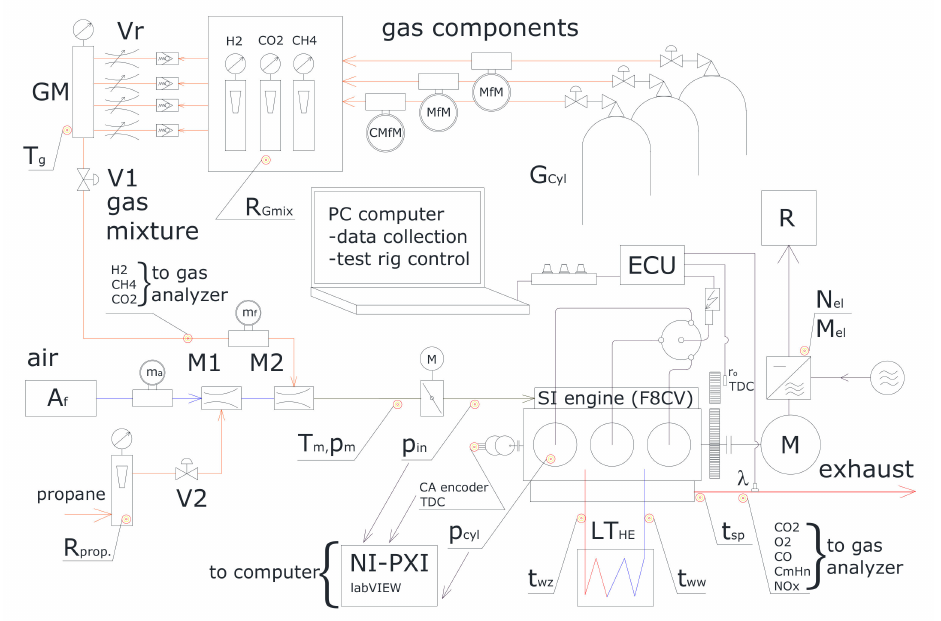
Figure 2. The experimental test rig